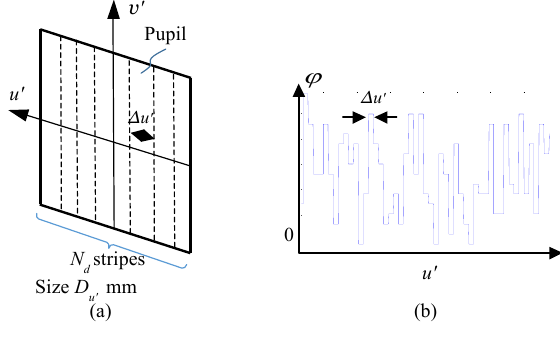
Figure 2. (a) Dimensions of the diffuser, scaled to exit pupil coordinates; (b) fragment of a randomized piecewise-constant phase function of the